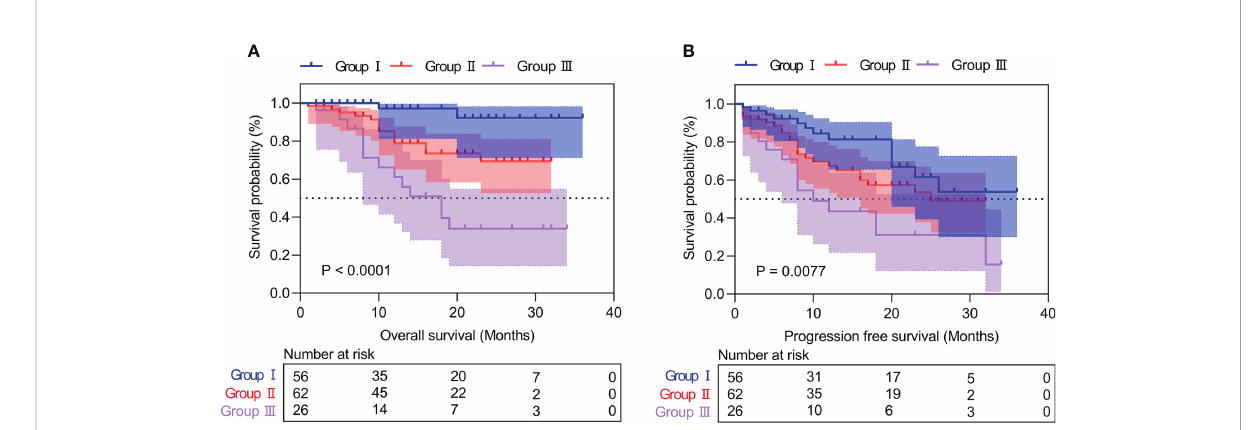
TABLE 4 Receiver operating characteristics analysis between IINS and other indicators in overall survival of the HCC patients. Variables